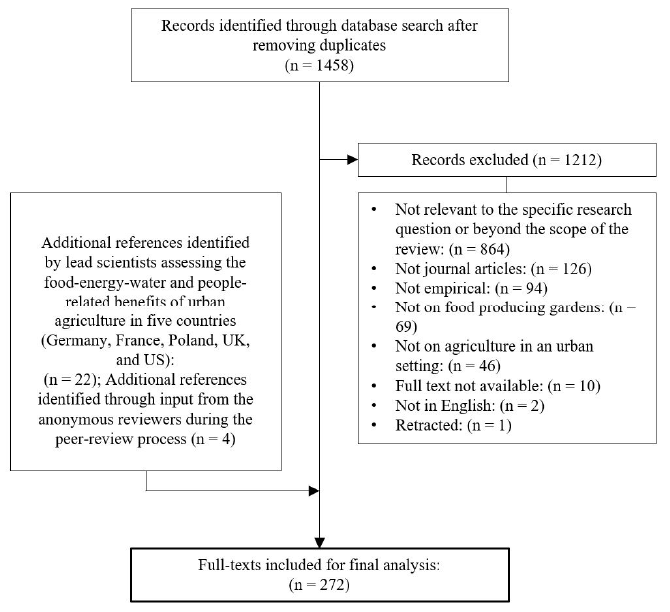
Figure 1. Searching and identification process of the full-text articles to be included in the review.